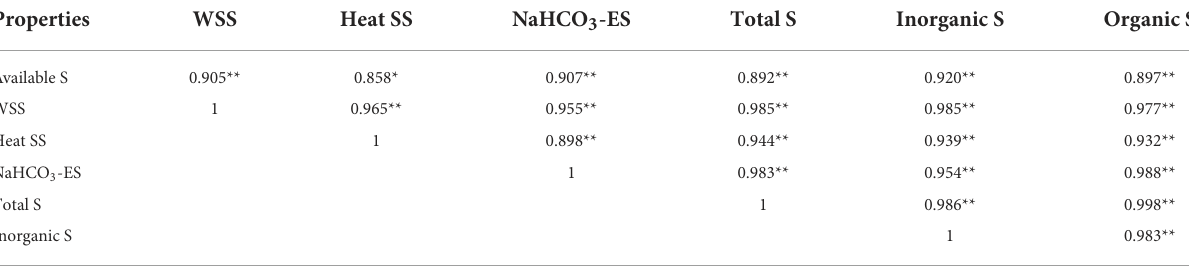
TABLE 4 Relationship (r-values) between S-fractions of rice-wheat cropping